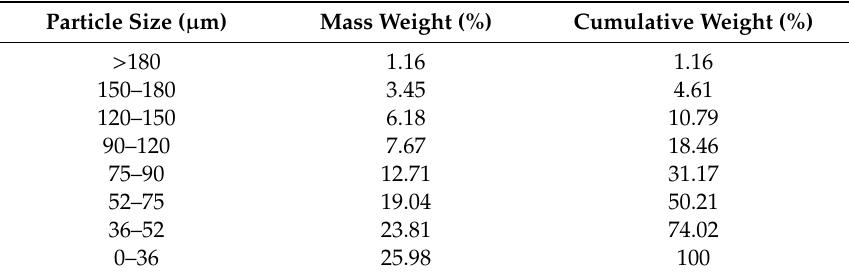
Table 1. Particle size distribution.